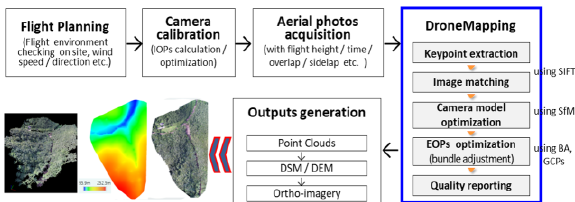
Figure 2 . Photogrammetry-based drone mapping procedure